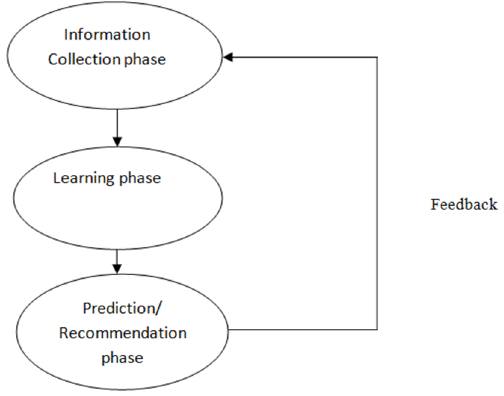
Figure 1. Phases of the recommender system.